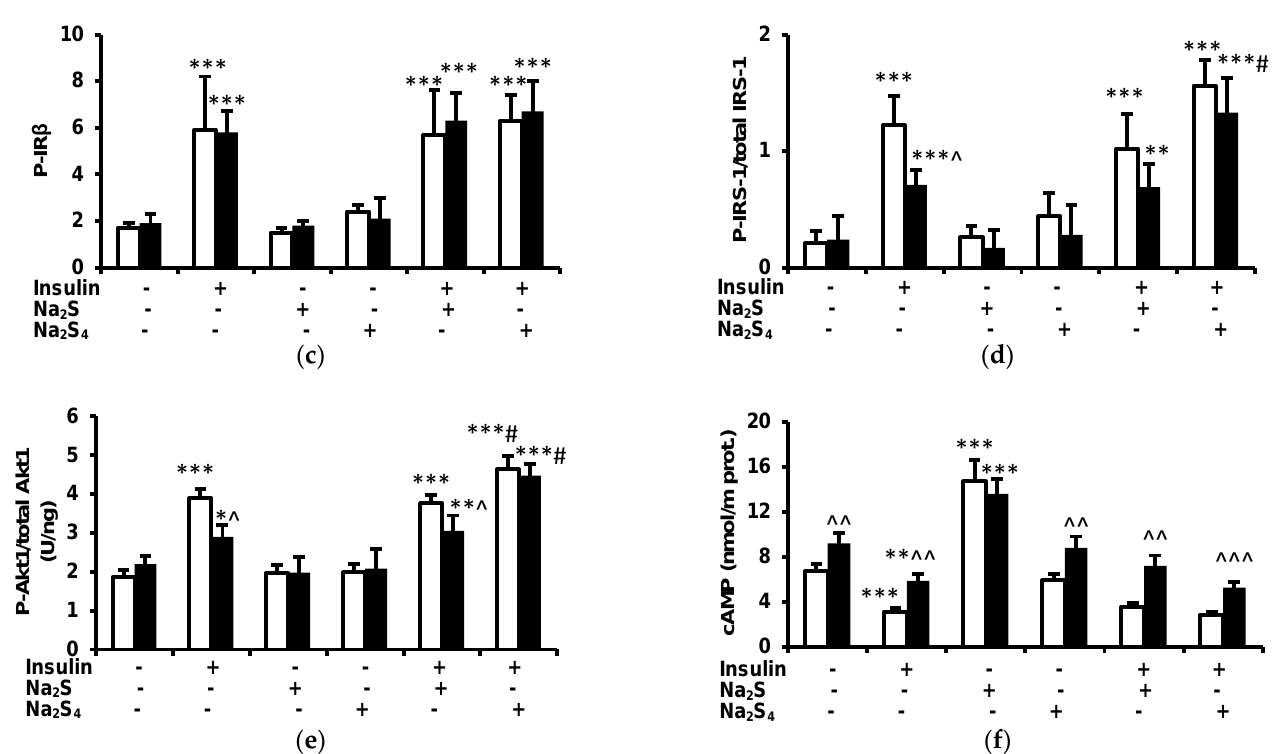
Figure 5. E ffect of insulin, Na 2 S, and Na 2 S 4 on glucose uptake ( a ), glycerol release ( b ), tyrosine phosphorylation of IRβ ( c ), tyrosine phosphorylation of IRS-1 ( d ), Akt1 phosphorylation ( e ), and cAMP concentration ( f ) in mesenteric adipose tissue isolated from lean (white) and obese (black) rats. * p < 0.05, ** p < 0.0, *** p < 0.001 vs. samples not treated with insulin, Na 2 S, and Na 2 S 4 collected from the respective group of rats (lean or obese), ^ p < 0.05, ^^ p < 0.01, ^^^ p < 0.001 vs. adipose tissue samples treated in the same manner collected from lean rats, # p < 0.05 vs. samples from the respective group (lean or obese) treated with insulin alone.